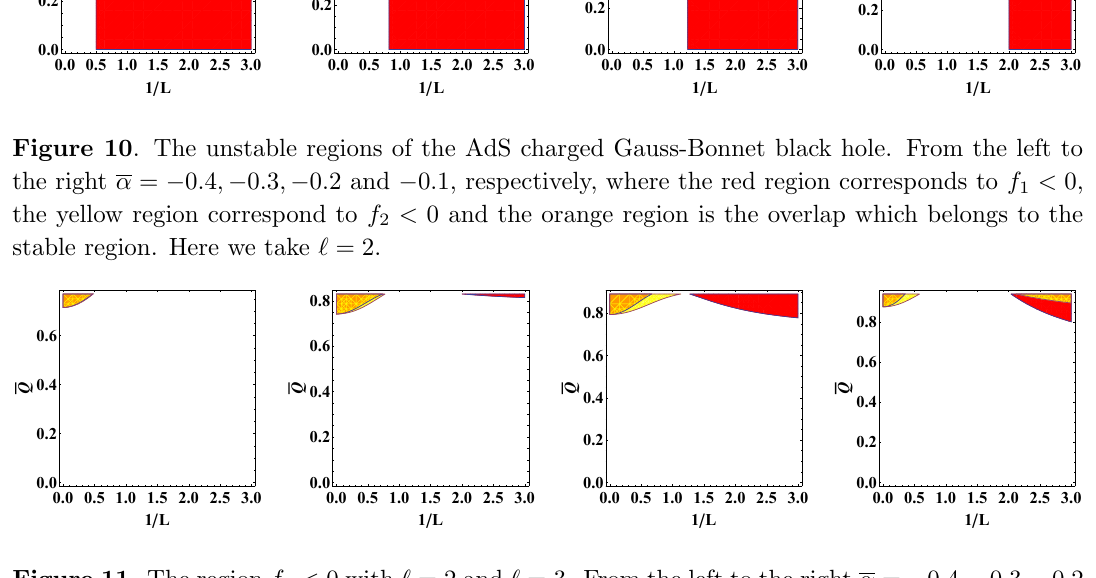
Figure 11 . The region f 2 < 0 with ‘ = 2 and ‘ = 3. From the left to the right (cid:11) = (cid:0) 0 : 4 ; (cid:0) 0 : 3 ; (cid:0) 0 : 2 and (cid:0) 0 : 1, respectively, where the red region corresponds to ‘ = 2, the yellow region correspond to ‘ = 3. The upper left corner shows that a larger ‘ leads to a larger unstable region. On the contrary the right upper corner shows that a larger ‘ corresponds to a smaller region. However, the right upper corner is the region overlapping with f 1 < 0 so that it actually belongs to the stable region. In any case, a larger ‘ always leads to a smaller unstable